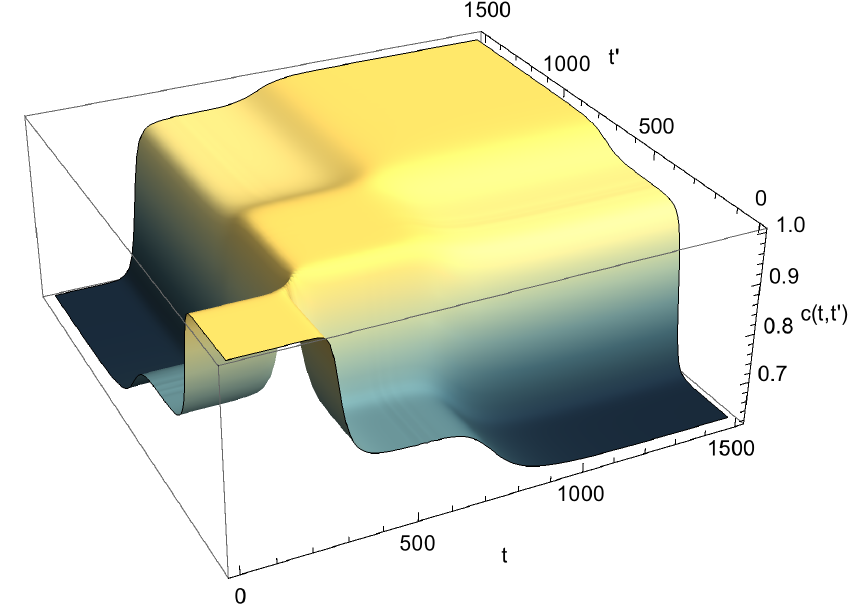
Figure 4: Representation of the correlation function c ( t , t (cid:48) ) along the reconstructed (see Sec. 6) instantonic solution that links a reference minimum ( s ε = − 1.167 to a neighboring minimum ( s ) reached through a saddle ( s 1 3 = − 1.1555 and with overlap q = 0.75 with s ergy ε . The plot shows correlation 2 1 equal to one on the diagonal and plateaux on other three different levels, correspond- = 0.957 between s ing to the overlaps q = 0.75 between s and s , q 1 2 23 = 0.619 between s q and s 13 1 3